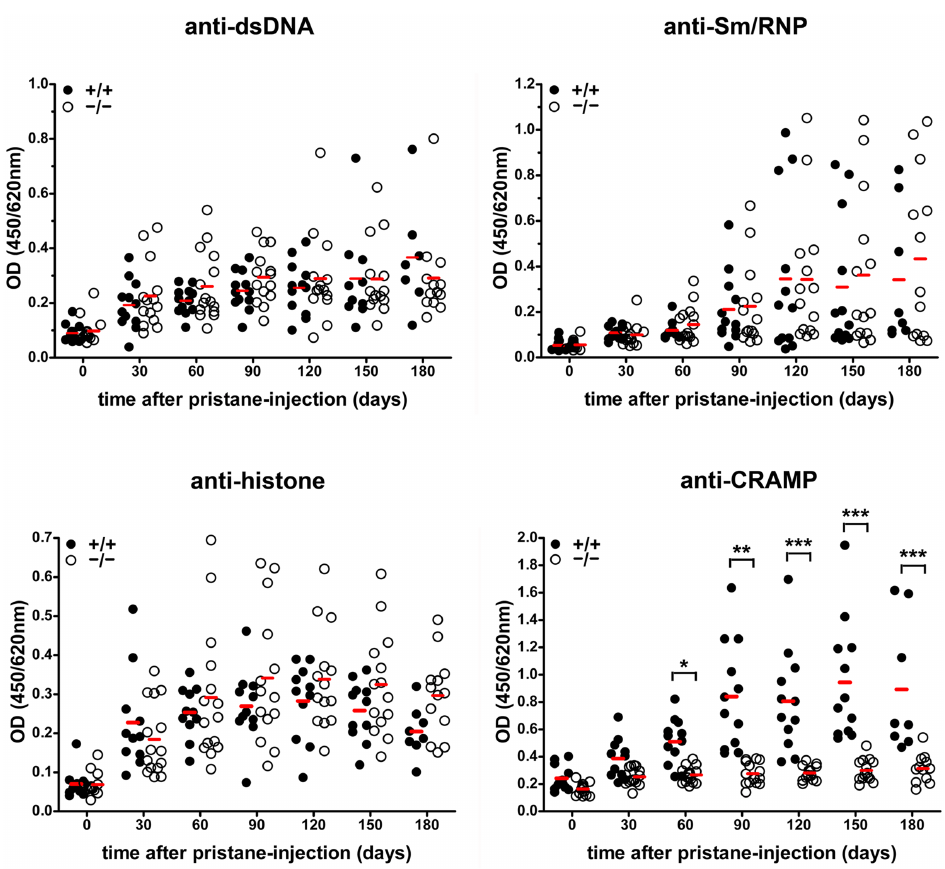
Fig. 4. Development of lupus autoAbs in C57BL/6 WT and CRAMP 2 / 2 mice. CRAMP 2 / 2 and CRAMP + / + mice develop similar levels of lupus autoantibodies after pristane-injection. Autoantibodies to dsDNA, Sm/ RNP, histone, and CRAMP were analysed in sera of naı¨ve and pristane-primed mice (n 5 11–15) by ELISA and compared by ANOVA with Bonferroni post-hoc test. Red horizontal bars show means. No significant differences could be found except for autoantibodies to CRAMP. *P , 0.05, ***P , 0.001.